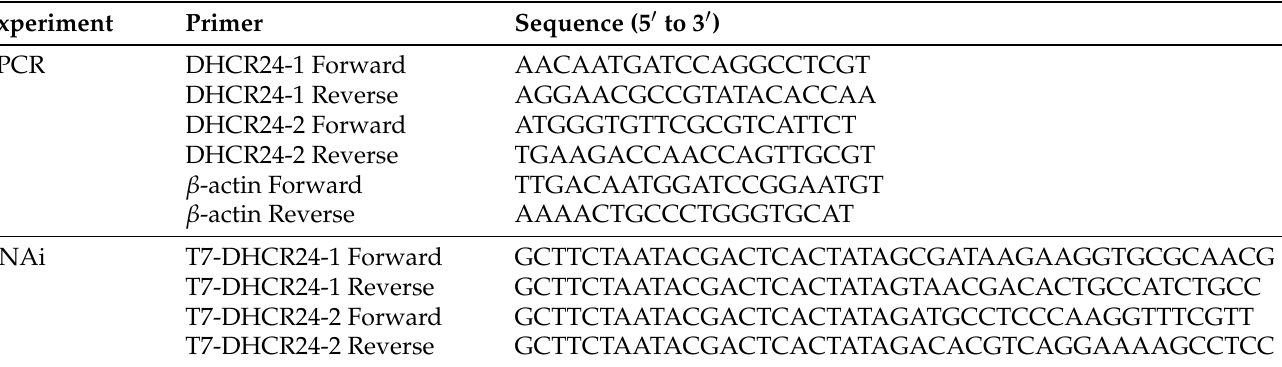
Table 2. Primers used in this